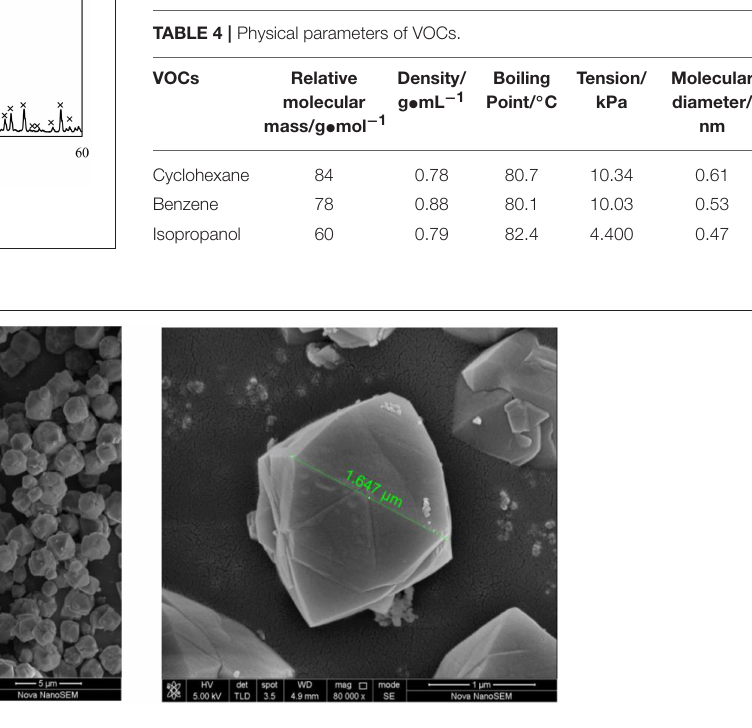
FIGURE 7 | SEM image of zeolite X